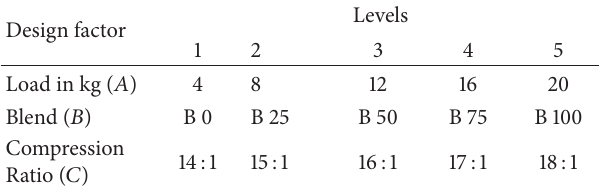
Table 1: Design factors and their levels.